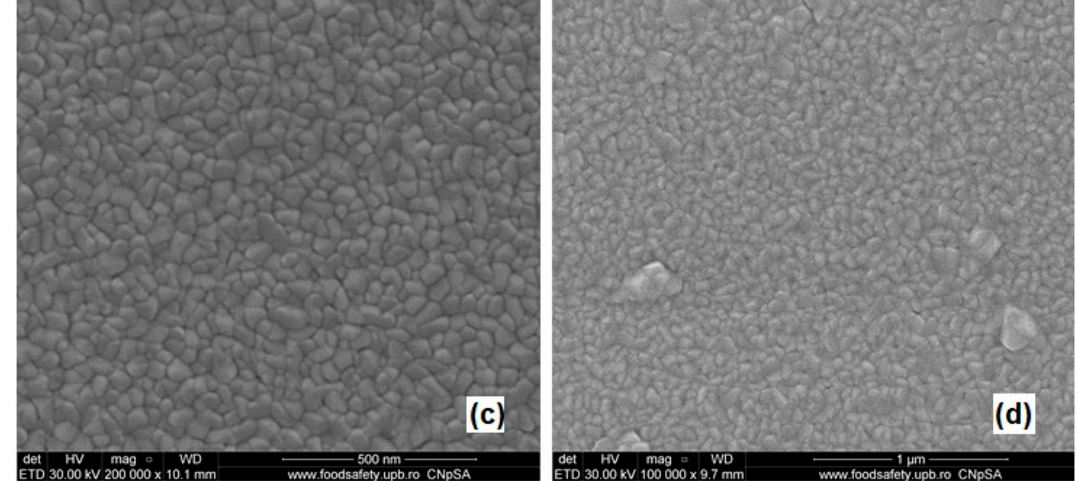
Figure 10. SEM images of Cu 2 O thin films deposited on quartz substrate: ( a ) Sample 0, ( b ) Sample 1, ( c ) Sample 2, and ( d ) Sample 3.